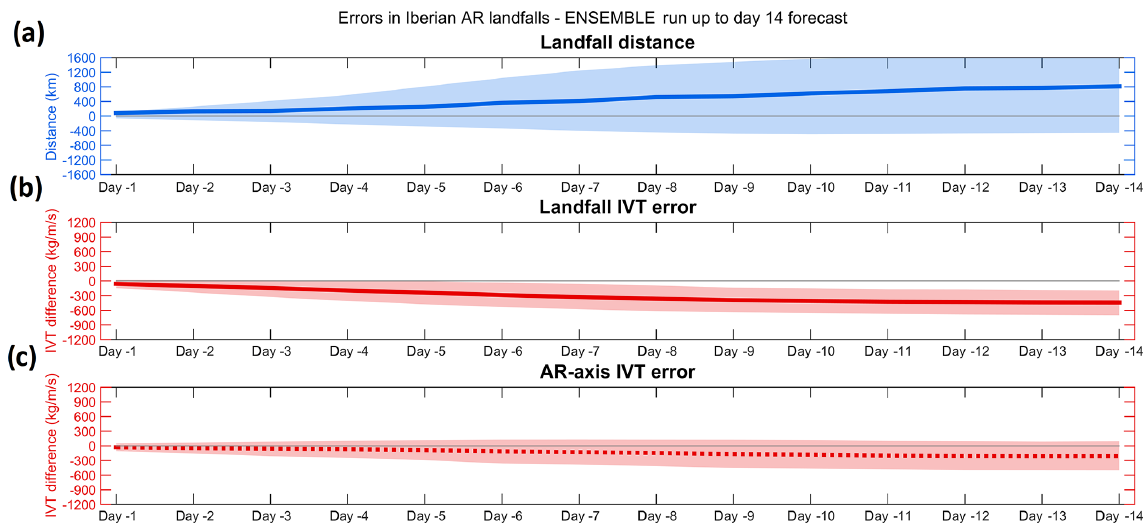
Figure 6. Verification of the accuracy of the ensemble forecast of IVT for all events affecting western Iberia during the extended winters between 2012 and 2016 is shown: (a) mean landfall distance errors (in kilometers) for the mean of the ensemble forecast (solid line) and the spread of the ensemble (shading); (b) as in (a) , but for the mean IVT error (in kgm − 1 s − 1 ) at the location of observed landfall; (c) as in (b) , but at the location of the maximum IVT in each